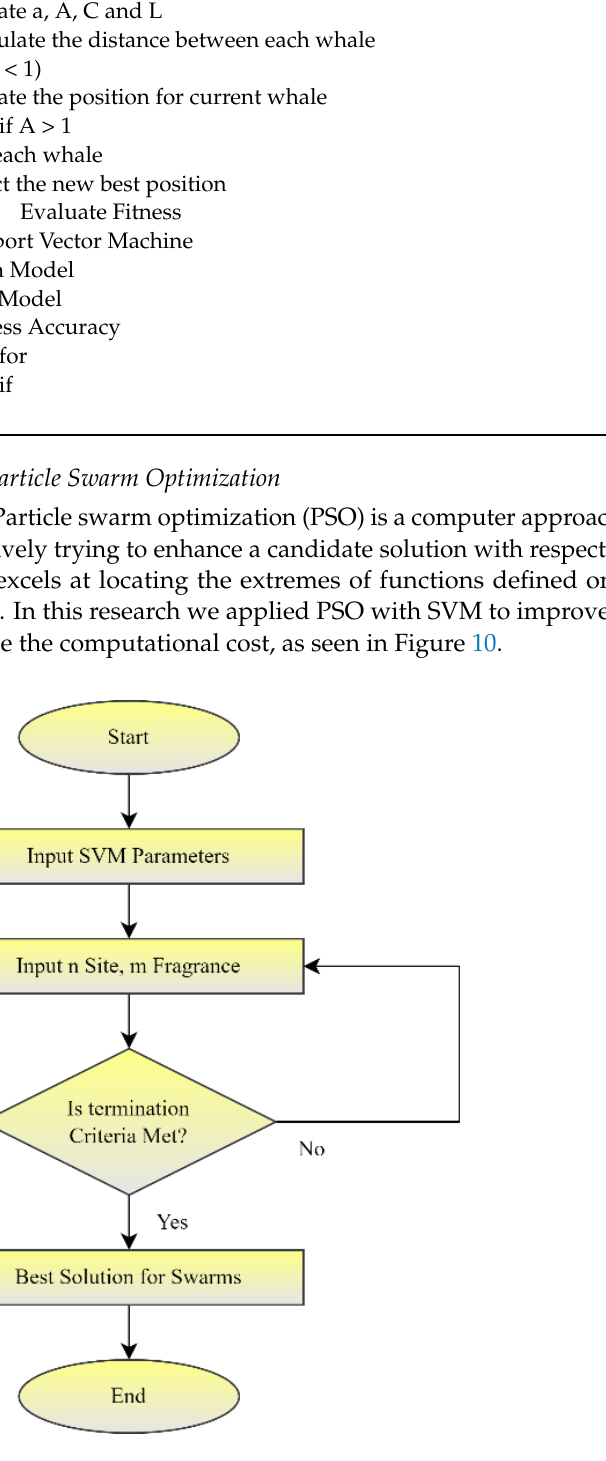
Figure 10. PSO ‐ SVM Algorithm. Figure 10. PSO-SVM Algorithm 4 shows the pseudocode for the PSO ‐ SVM algorithm. Algorithm 4. The PSO ‐ SVM pseudocode.